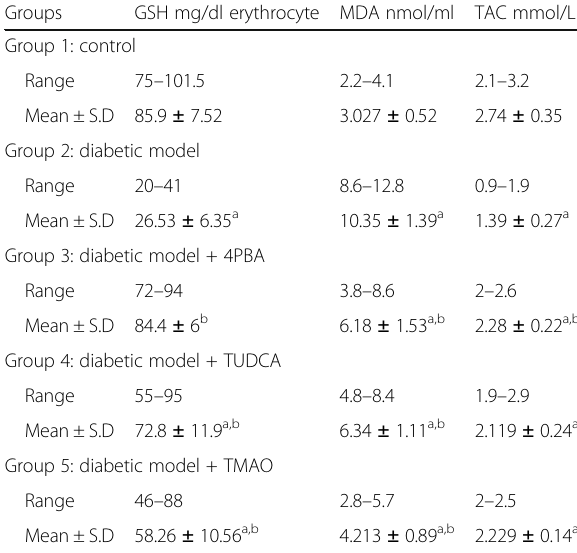
Table 3 Blood glutathione (GSH), serum malondialdehyde (MDA), and serum total antioxidant capacity (TAC) in control and experimental